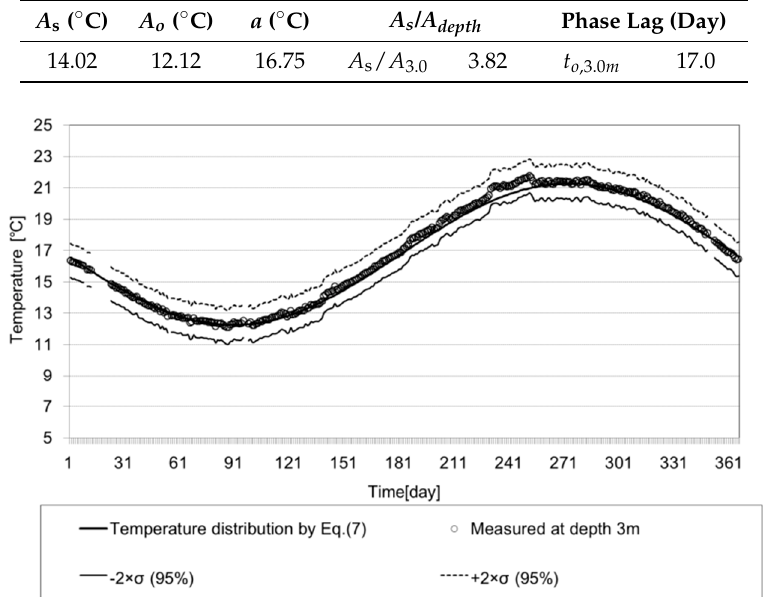
Figure 10. ( a ) Field measurement points; ( b ) equipment installation in the field. Table 6. Coefficients for estimating ground temperature in Changwon, Korea.